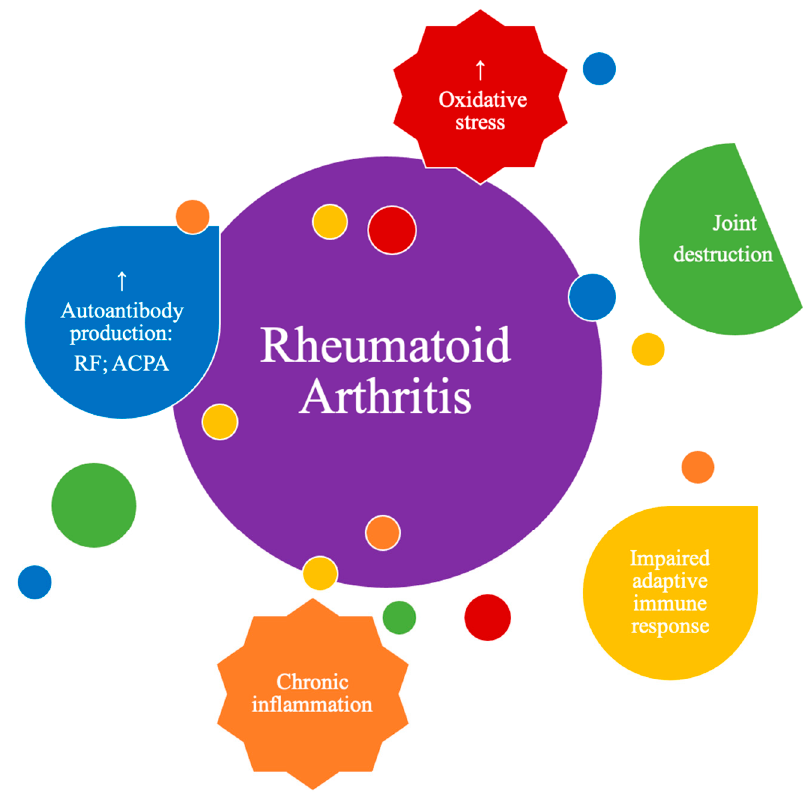
Figure 1. Main physio ‐ pathological alterations that occur in rheumatoid arthritis